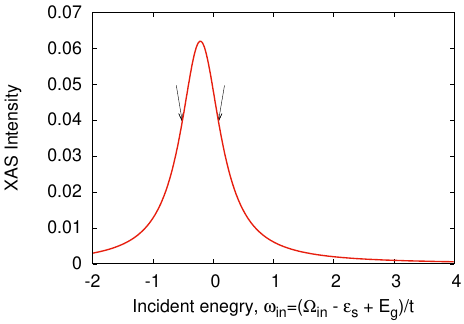
Figure 9. XAS spectrum in a “Cu-O-Cu” molecule. Arrows show the input X-ray frequencies. The strong temperature dependence of the RIXS spectrum was first observed for Li 2 CuO 2 and CuGeO 3 edge-shared cuprate compounds in Ref. [34] The XAS spectrum also depends on temperature, but this dependence is